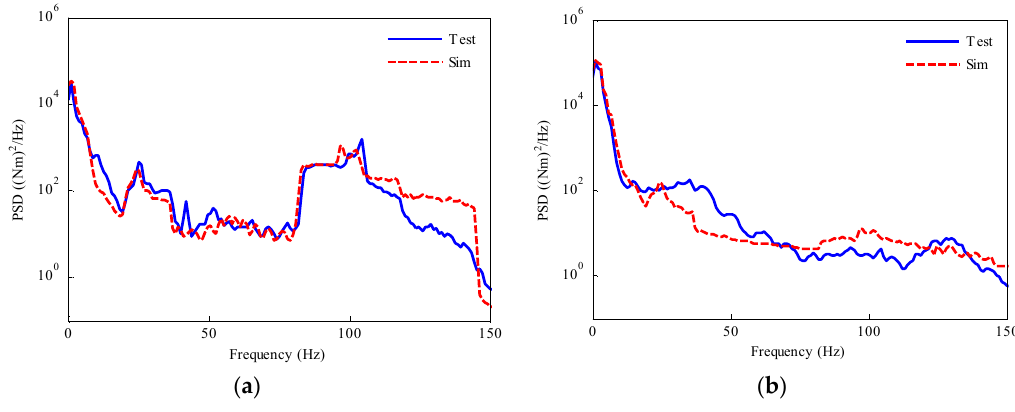
Figure 8. PSD analysis ( a ) of the engine output torque and ( b ) the transmission output torque.